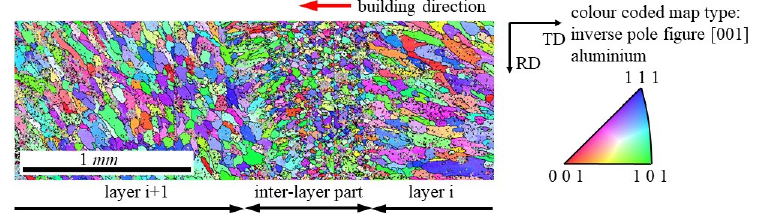
Figure 9. Crystal orientation map ([001] = ND, [010] = TD, [100] = RD) of WAAM-fabricated AA2319, according to the local coordinate system for the EBSD analysis; the colour coding shows that the grains are oriented randomly, resulting in low micro-texture sharpness; calculation of Taylor factors based on at least 8100